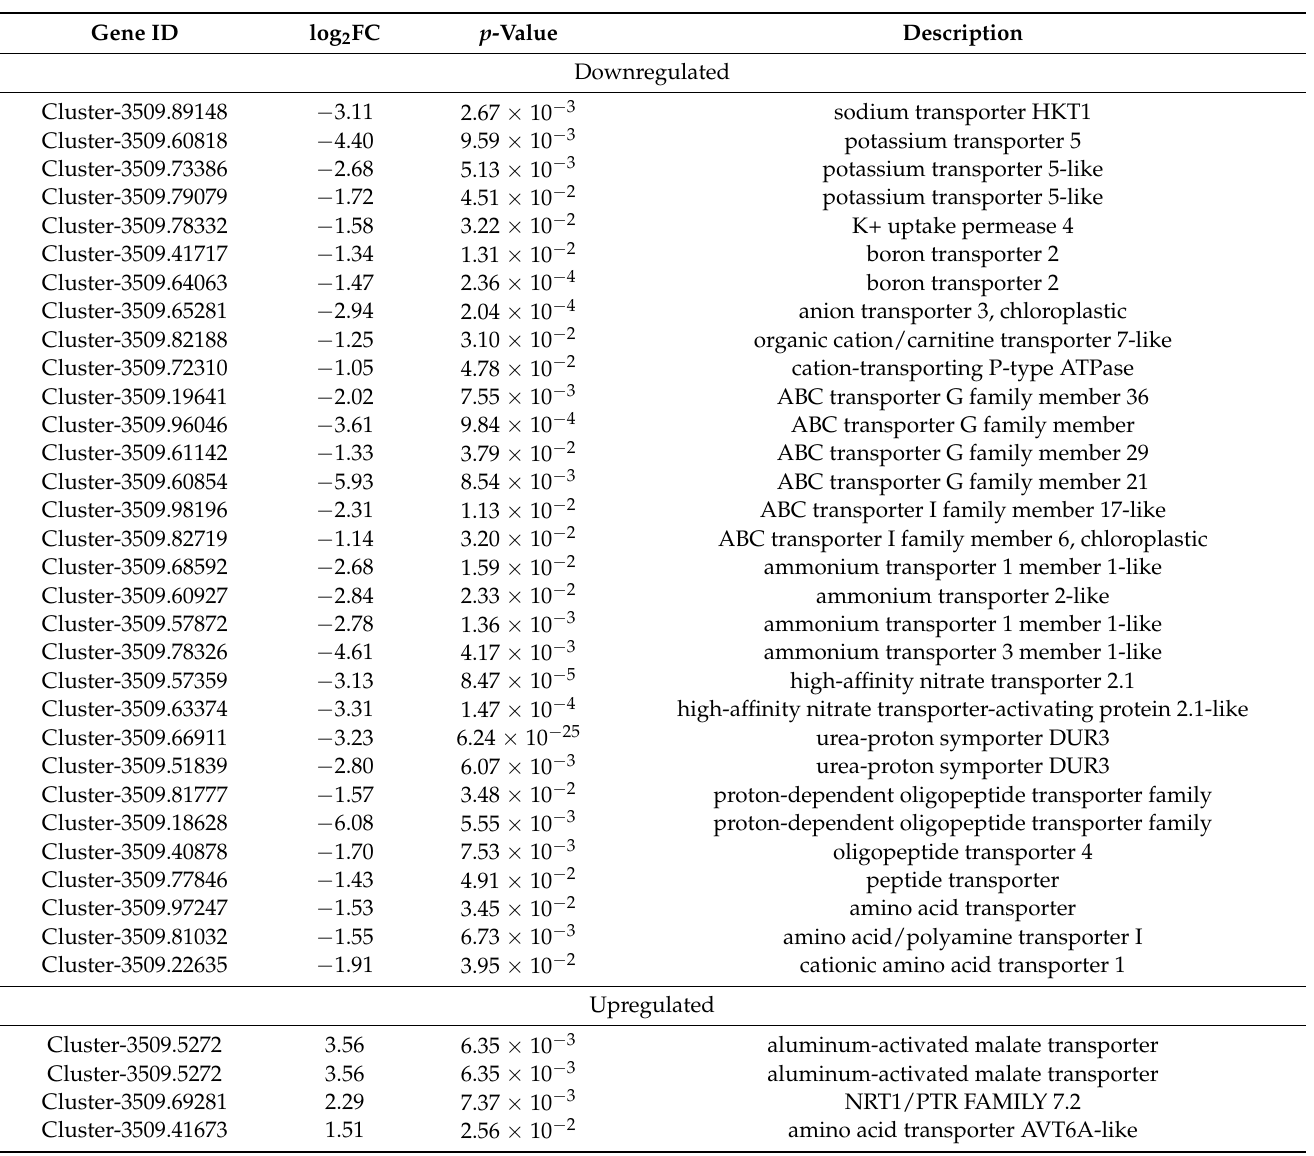
Table 2. Differentially expressed genes related to the transport of ions in water lily roots under salt